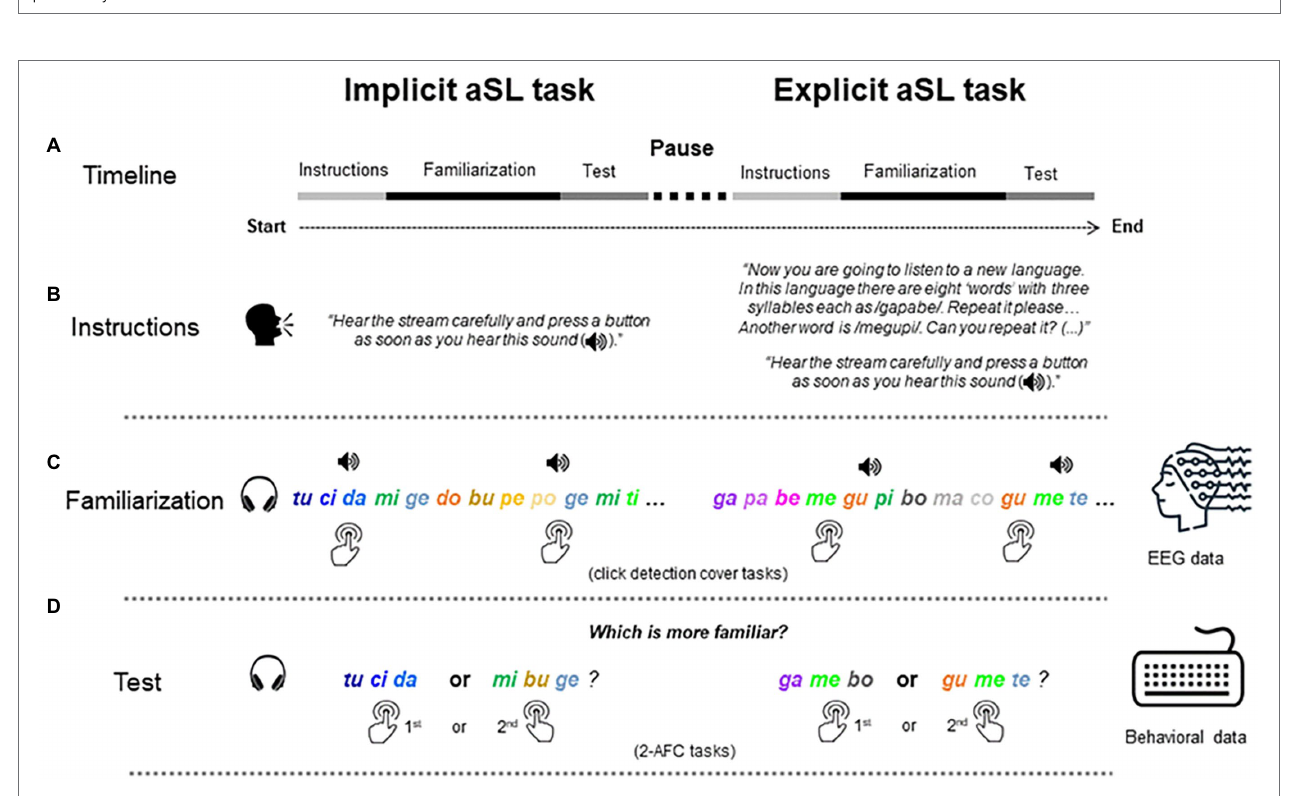
FIGURE 1 | Visual depiction of the high- and low-TP “Words” used in the auditory streams. High-TP, high-transitional probability “words”; Low-TP, low-transitional probability